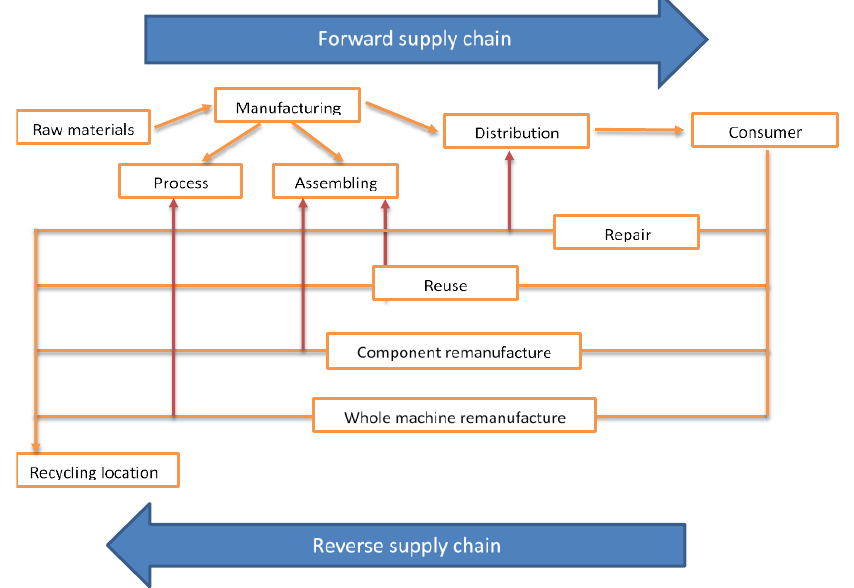
Figure 6. Structure of a CLSC .